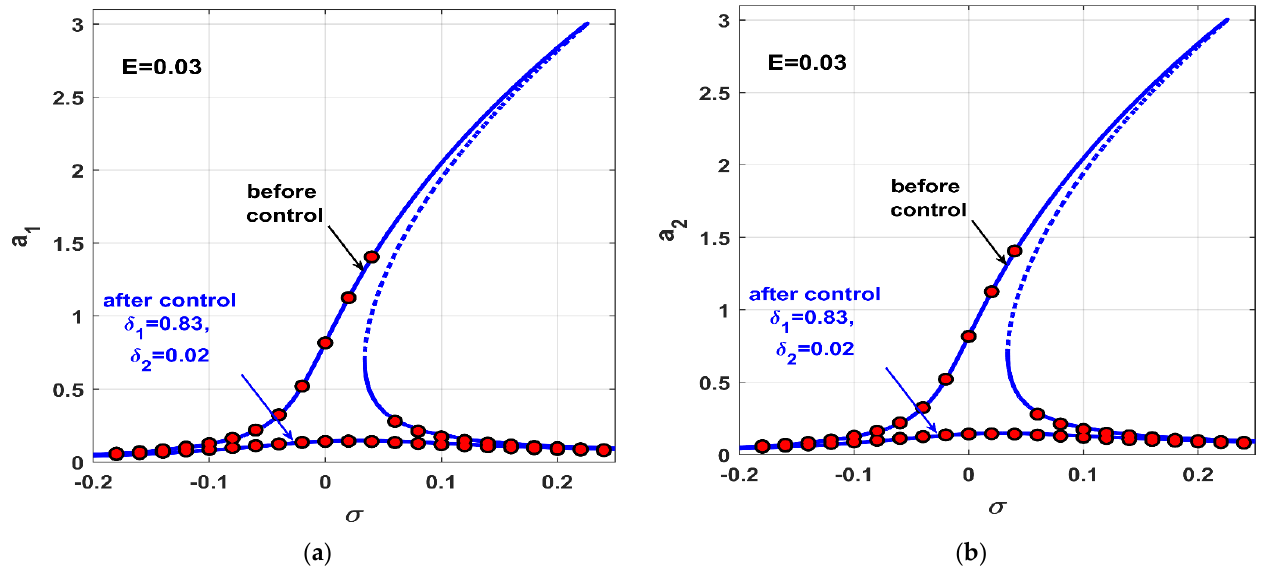
Figure 20. 𝜎 − response curve of the studied Jeffcott rotor system before control and after optimal control (i.e., 𝛿 (cid:2869) = 0.83 and 𝛿 (cid:2870) = 0.02 ): ( a ) oscillation amplitude 𝑎 (cid:2869) versus 𝜎 when 𝐸 = 0.03 , and ( b ) oscillation amplitude 𝑎 (cid:2870) versus 𝜎 when 𝐸 = 0.03 .